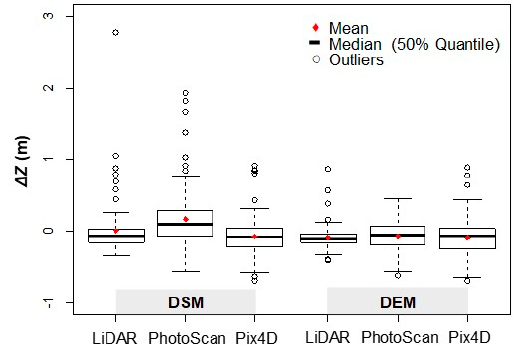
Figure 5. Box plots for comparison of Δ Z error for each model (No. of checkpoints = 104). Table 4. Accuracy measures of LiDAR based and UAV-derived models (checkpoints = 104).